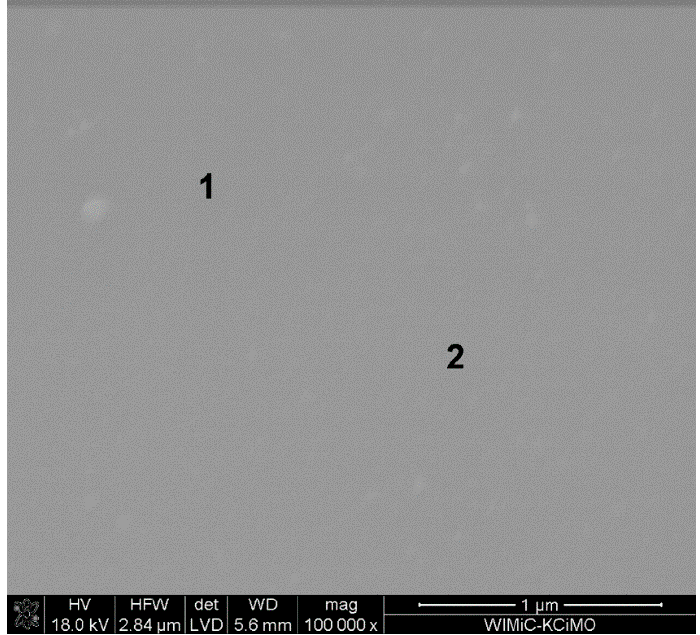
Figure 1. Surface morphology of the sample no. 1 (based on isopropanol-NaOH synthesis). Magnification 100,000×. Numbers indicate areas of EDX analysis.